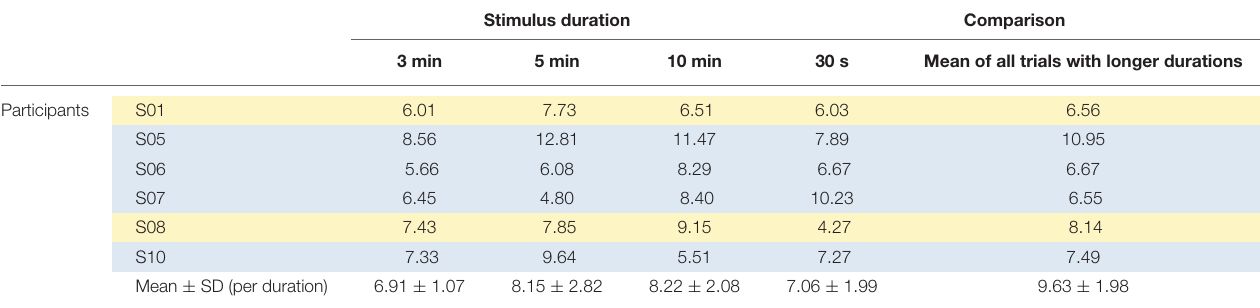
TABLE 3B | OKAN-I peak velocity (deg/s): participants without